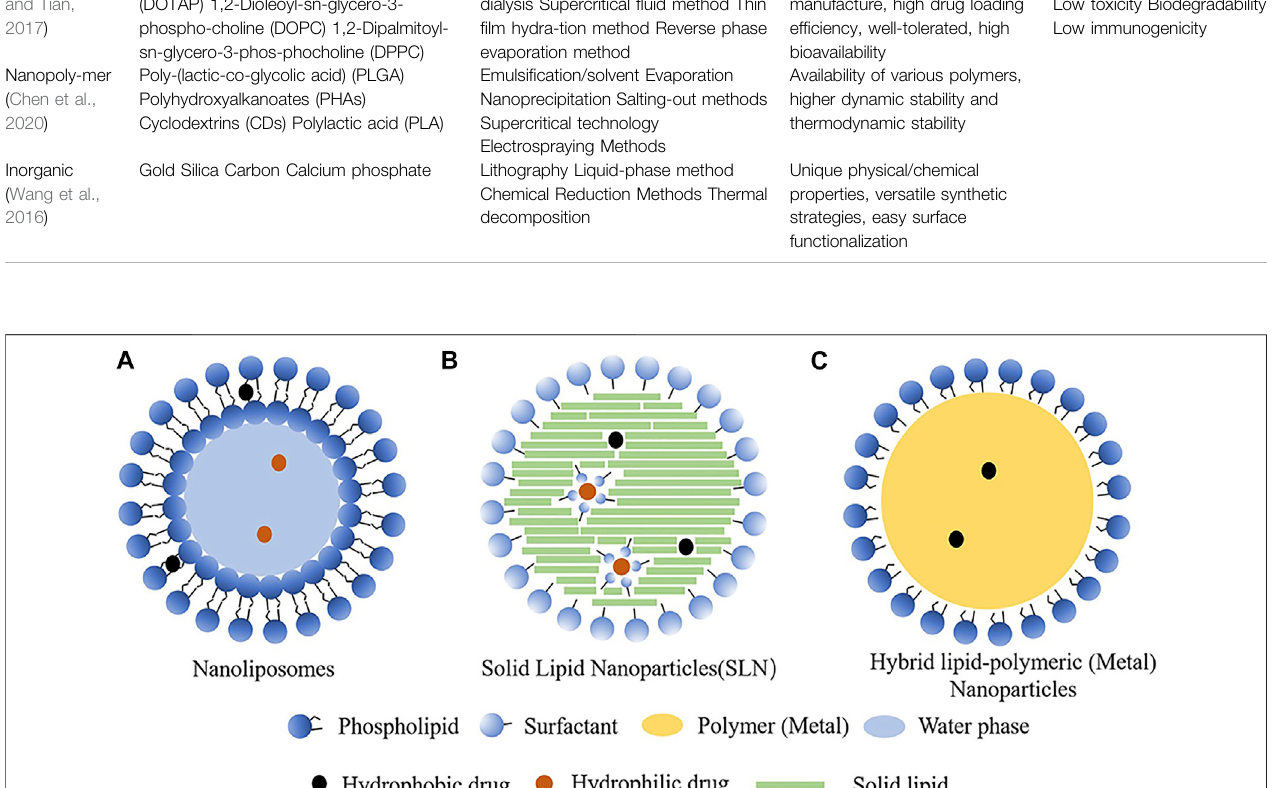
FIGURE 4 | Schematic diagram of different types of lipid nanoparticles: (A) Nanoliposomes (B) SLN (C) Hybrid lipid — polymeric (metal) Nanoparticles.